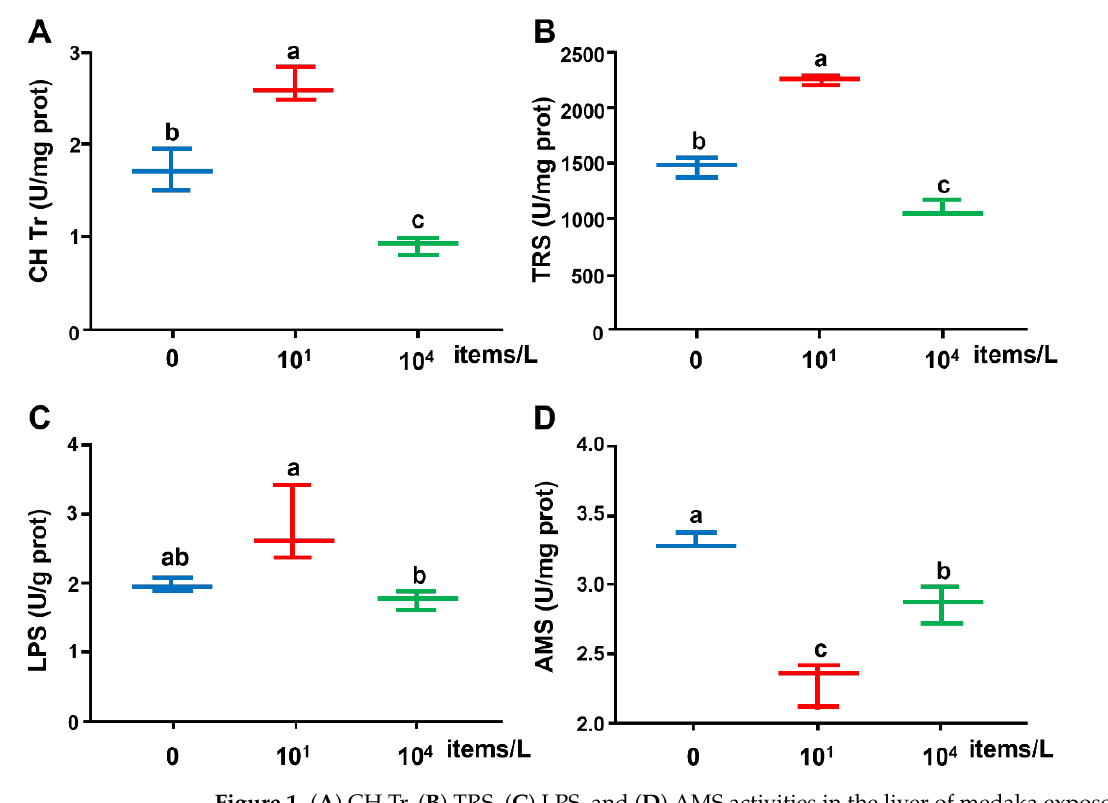
Figure 1. ( A ) CH Tr, ( B ) TRS, ( C ) LPS, and ( D ) AMS activities in the liver of medaka exposed to NPs